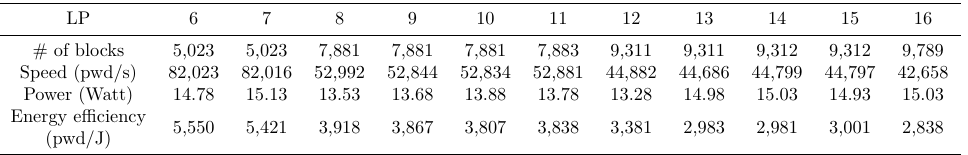
Table 4: System performance of the proposed